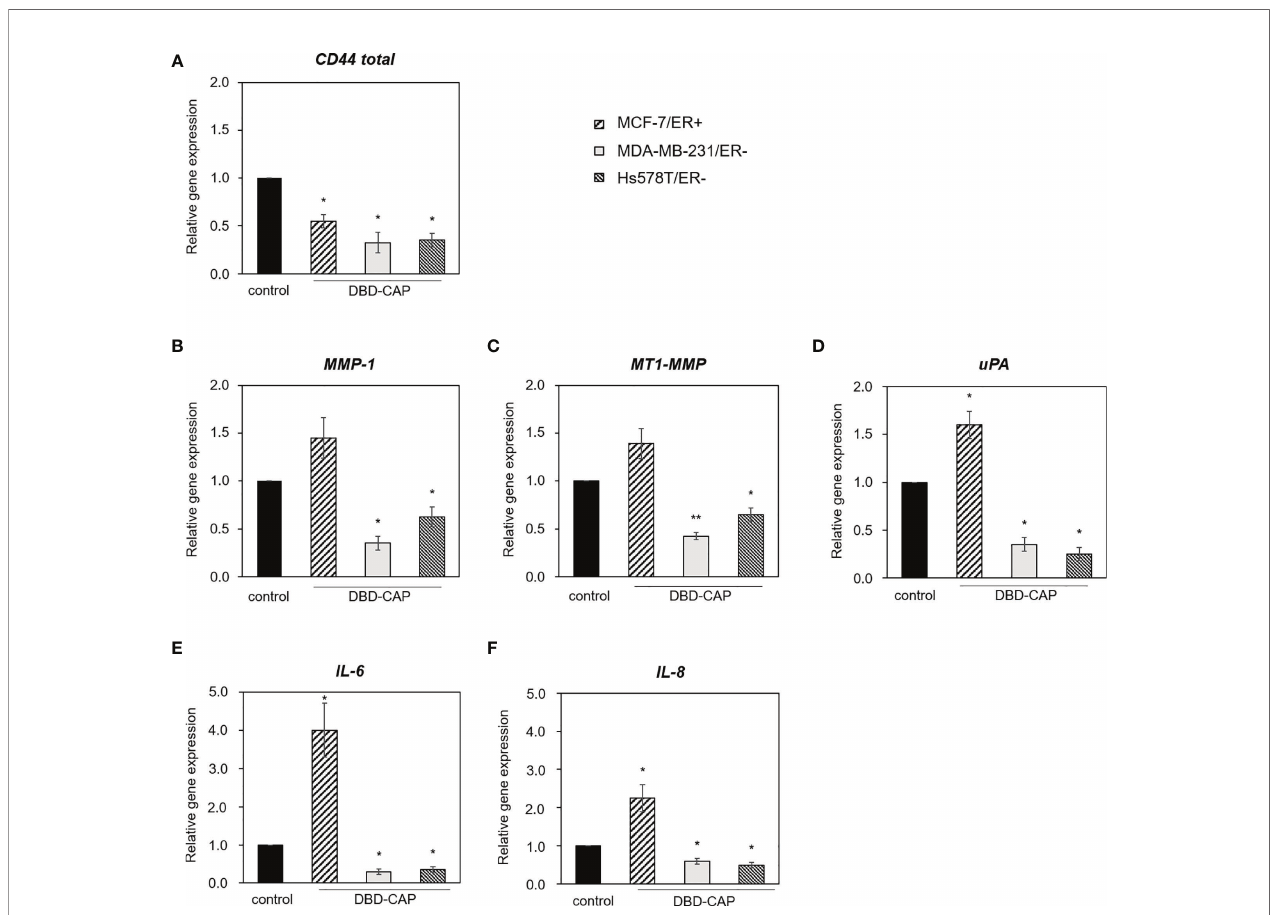
FIGURE 10 | DBD-CAP regulates the expression of matrix effectors in breast cancer cells. Quantitative qPCR analysis of (A) CD44 , (B) MMP-1 , (C) MT1-MMP , (D) uPA , (E) IL-6 and (F) IL-8 in MCF-7/ER+, MDA-MB-231/ER- and Hs578T/ER- cells treated with mild (0.5 kHz/27.6 kV) direct DBD-CAP for 4 min. The values represent the mean ± SD of 3 (at least) independent experiments. Asterisks illustrate signi fi cant differences between control (untreated) and DBD-CAP-treated cells (* p < 0.05, ** p <